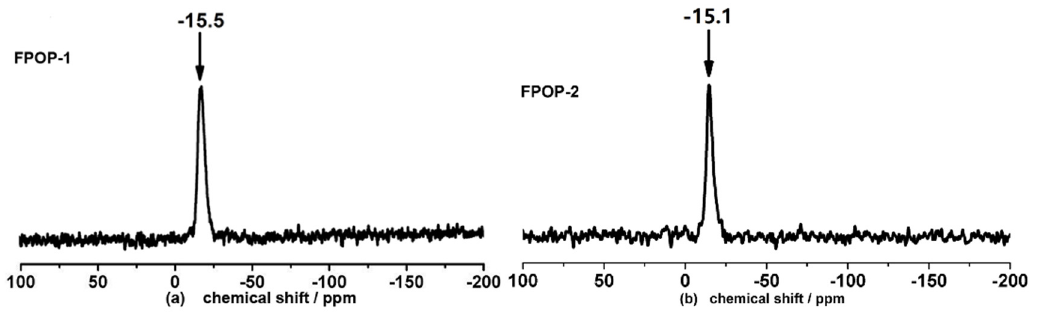
Figure 3. Solid-state 29 Si NMR spectra of FPOP-1 ( a ) and FPOP-2 ( b ).